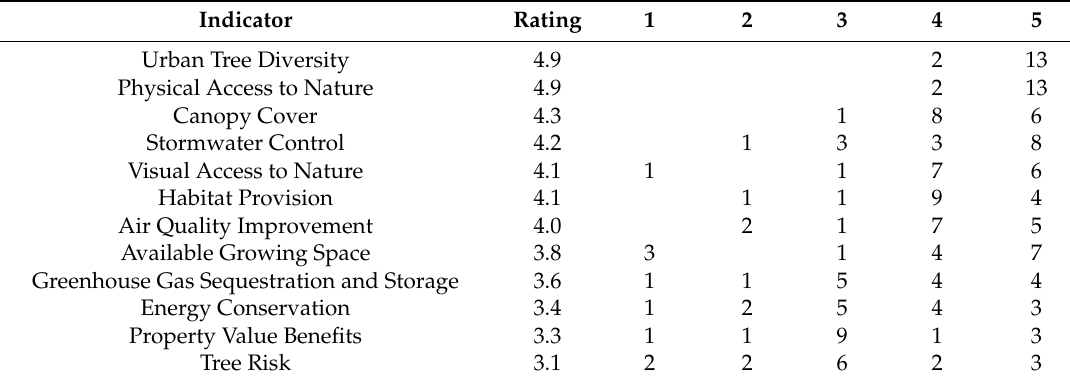
Table 1. Mean rankings and frequency of rating, all participants ( n =